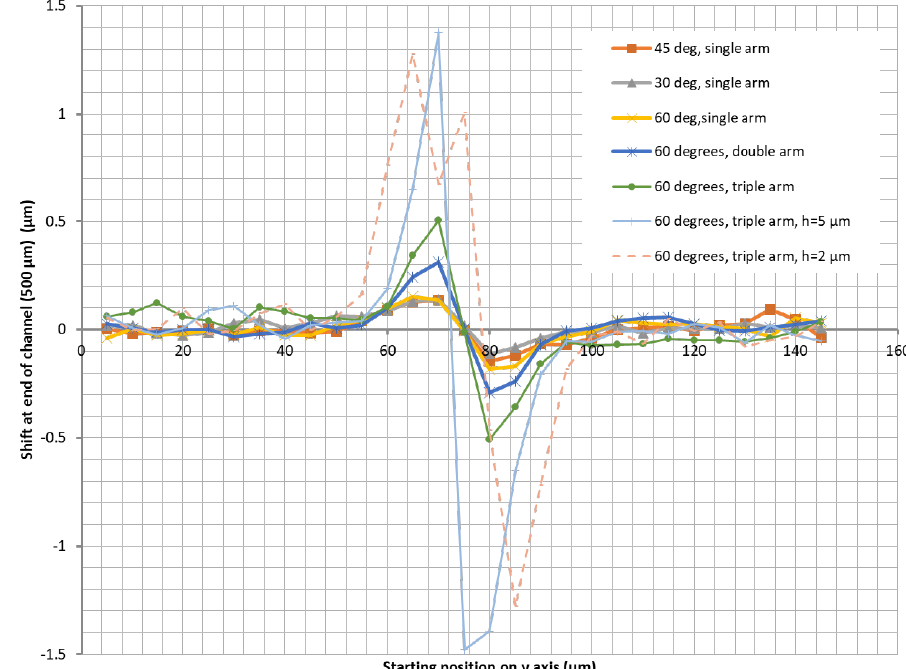
Figure 5. Particle displacement along the channel width after 500 µm of channel length under the influence of dielectrophoretic forces. Unless otherwise indicated, the channel height is 20 µm. The figure shows that the displacement is larger for smaller but unrealistic channel heights. Double refers to electrodes having only two “teeth” instead of the three shown in Figure 1b, which in this graph is indicated as “triple”.